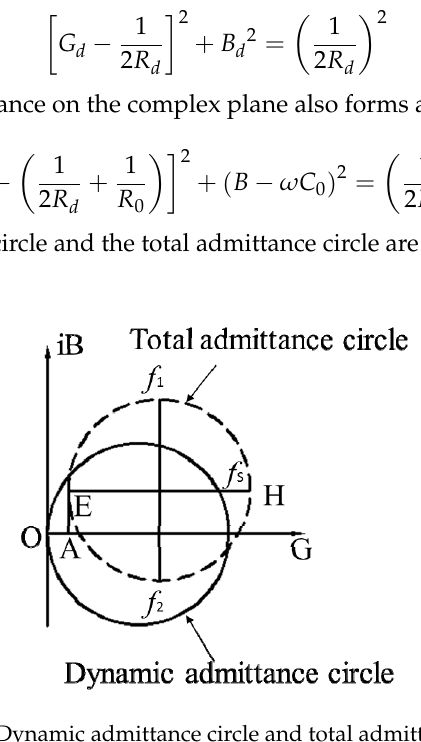
Figure 2. Dynamic admittance circle and total admittance circle.